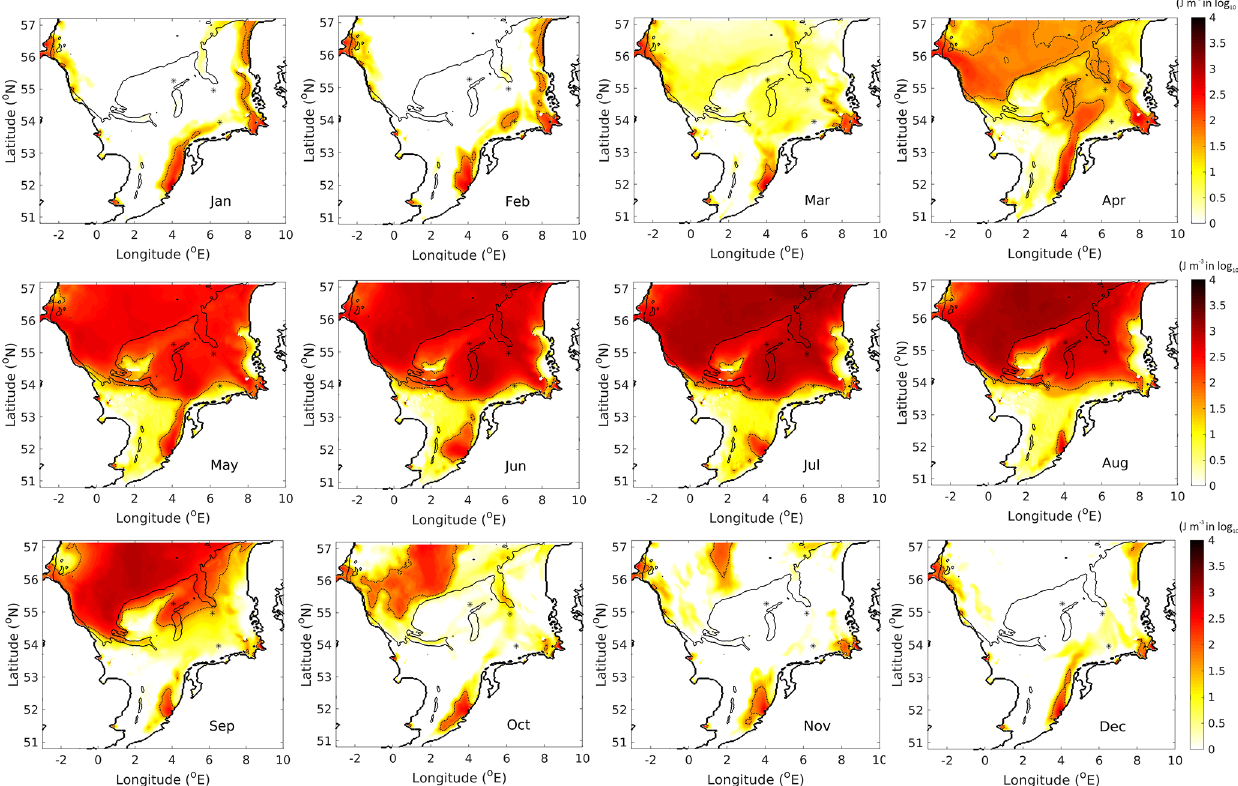
Figure 6. Evolution of the monthly mean potential energy anomaly φ (see Eq. 1, unit: Jm − 3 on a log 10 scale) for 2018. The dashed line indicates the location where φ = 1 . 7Jm − 3 on log 10 scale (or φ = 50 Jm − 3 ). The water column is considered to be stratified when φ is above this value. Thin black lines indicate the location of the 50m isobath.